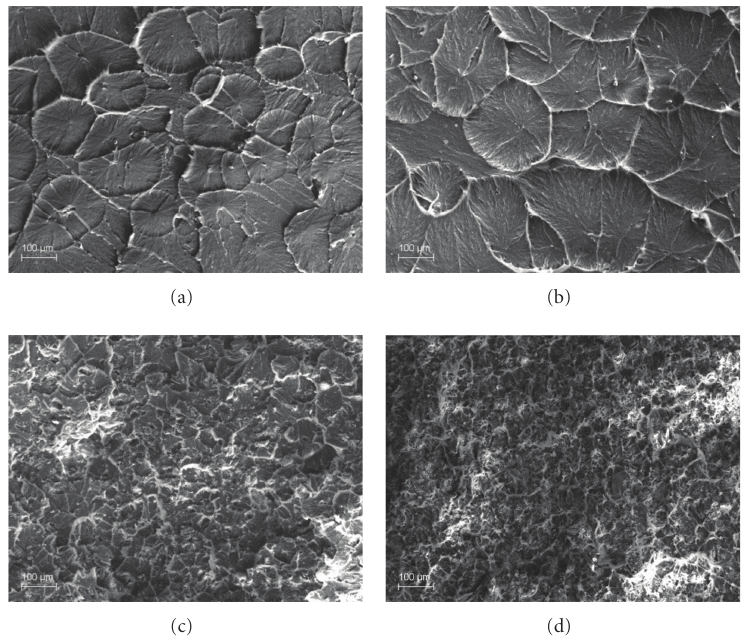
Figure 6: Permolecular structure of the pure UHMWPE (a), nanocomposite UHMWPE +0.5wt.% HA (b) and microcomposites: UHMWPE +10wt.% HA (c), UHMWPE +20 wt.% HA (d).